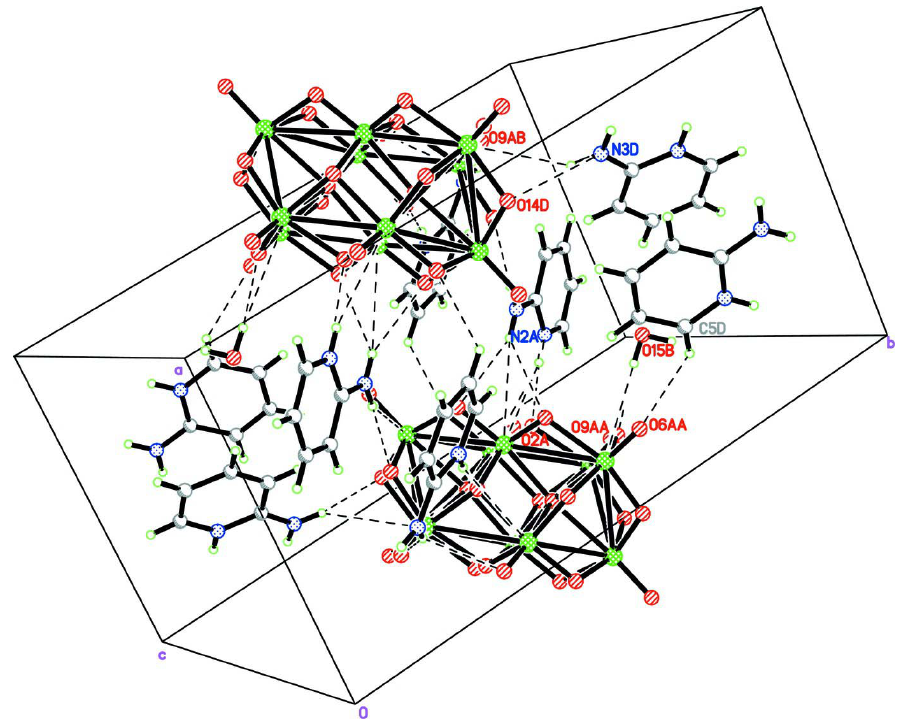
Figure 1 A view of the structure of (I) with displacement ellipsoids drawn at the 30% probability level; H atoms and the water molecule are omitted for